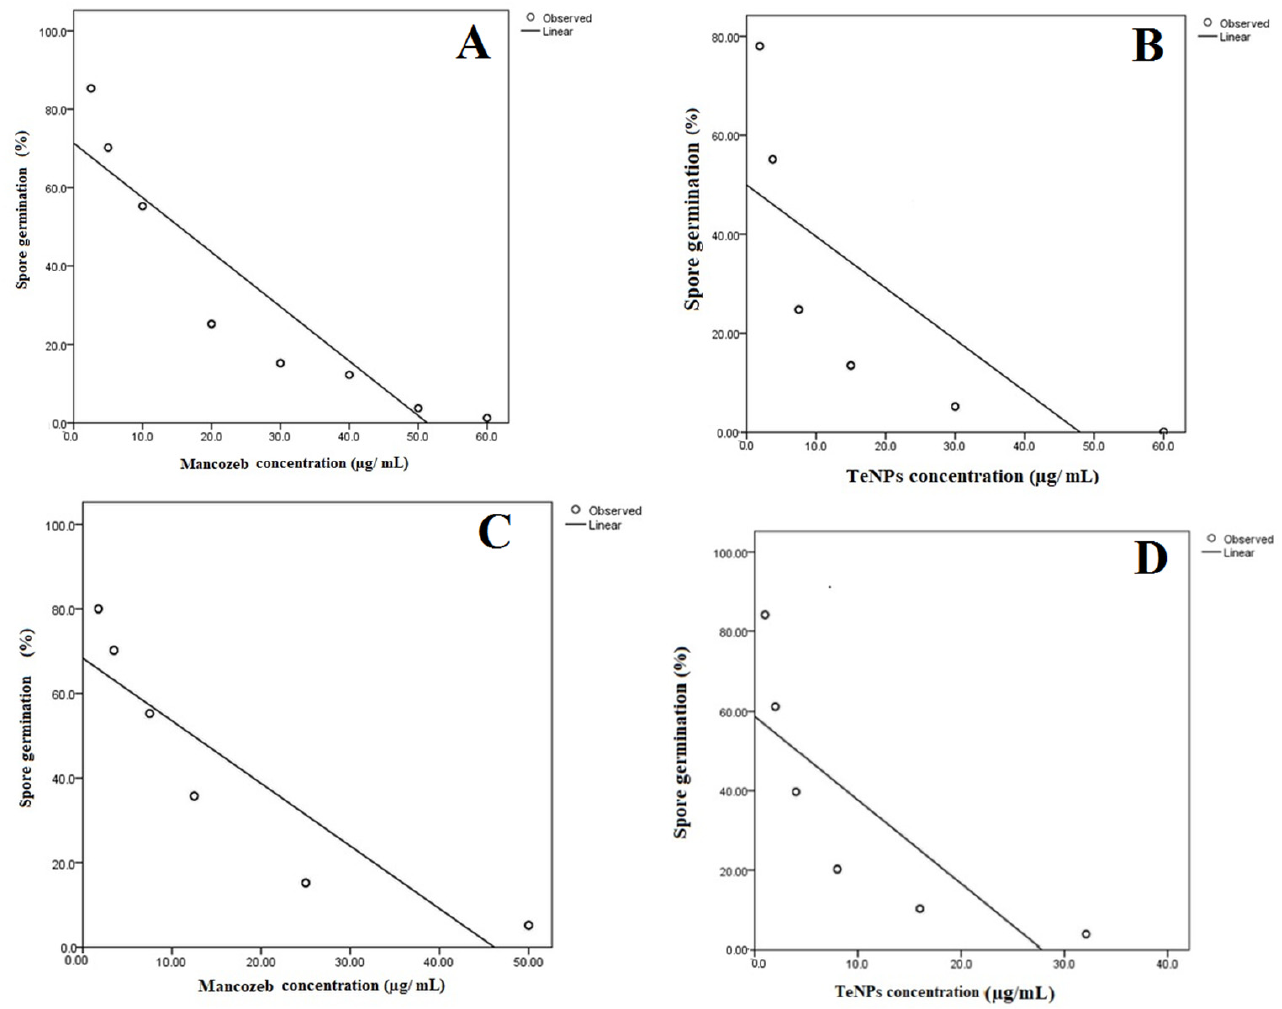
Figure 9. Linear regression model fit of spore germination. ( A ) F. oxysporum treated with mancozeb, ( B ) F. oxysporum treated with TeNPs, ( C ) A. alternata treated with mancozeb, ( D ) A. alternata treated with